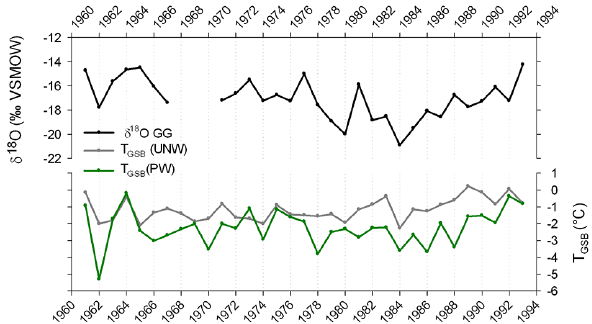
Figure 6. Annual δ 18 O from the Grenzgletscher (black), together with the annual mean temperature at the Grand Saint Bernard sta- tion. In grey the unweighted (UNW) temperature, in green the precipitation-weighted (PW) temperature, obtained as described in Sect.